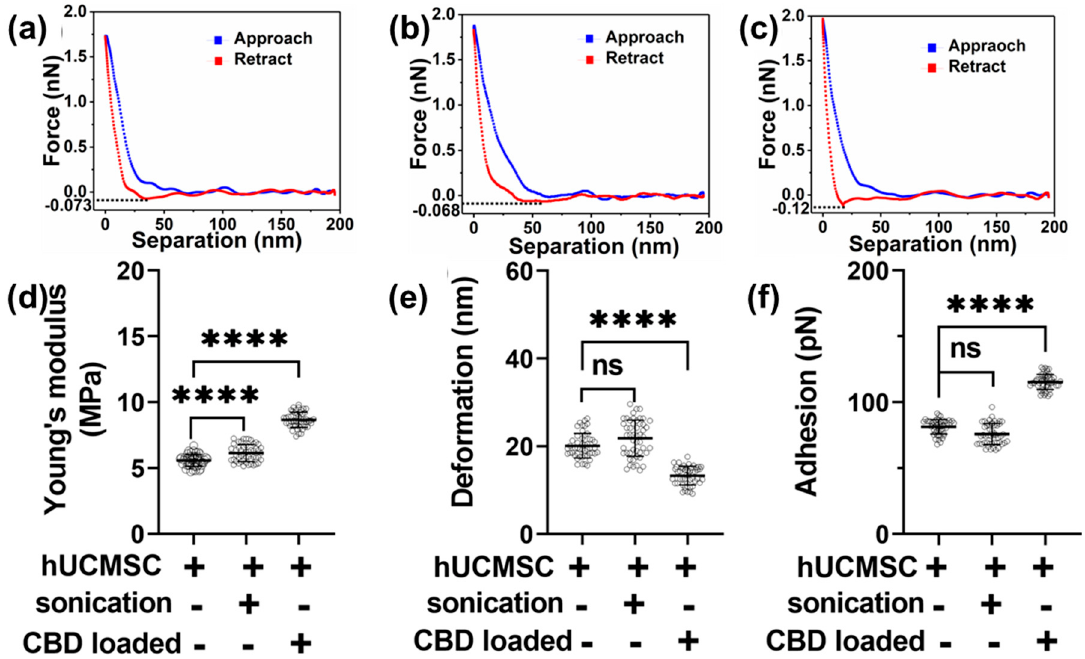
Figure 3. Nanomechanical characteristics of human mesenchymal stem cell (hUCMSC) EVs under various conditions. A representative force-separation curve displaying adhesion value corresponding to EVs derived from ( a ) hUCMSC, ( b ) hUCMSC post sonication (control), ( c ) CBD loaded hUCMSC. Nanomechanical attributes displaying ( d ) Young’s modulus, ( e ) Deformation, and ( f ) Adhesion. (Statistical significance: ns; not significant. ****; p <